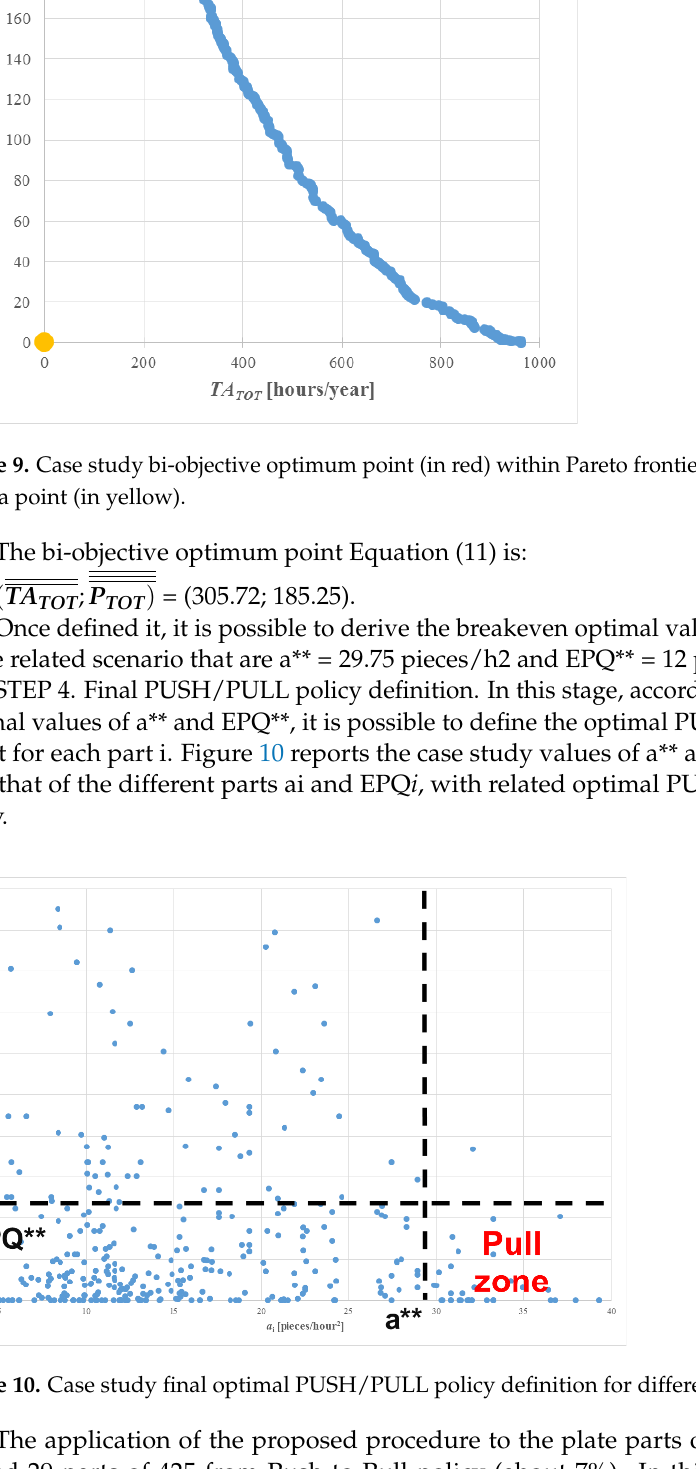
The application of the proposed procedure to the plate parts of the case company moved 29 parts of 425 from Push to Pull policy (about 7%). In this hybrid Push/Pull scenario, compared with that of the previous pure Push policy, the total number of stocked pallets at the warehouse decreases by about 27%, while the total setup time increases by about 3.5%. The results demonstrate that the application of the proposed bi-objective optimization model reduces the stocked